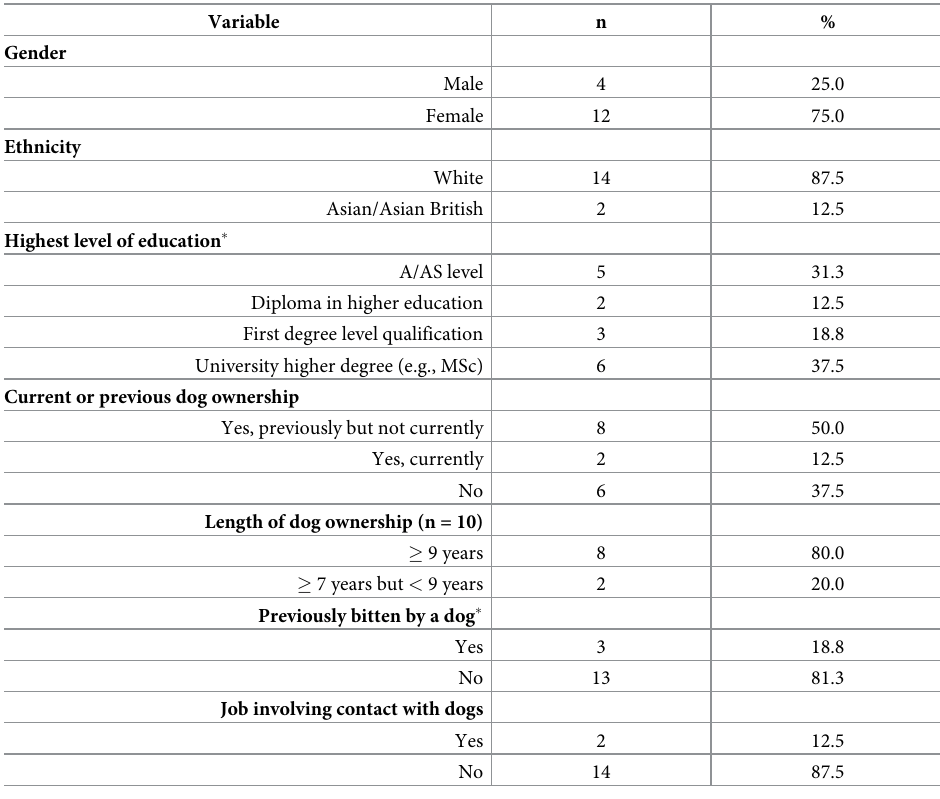
Table 1. Participant demographics and dog related